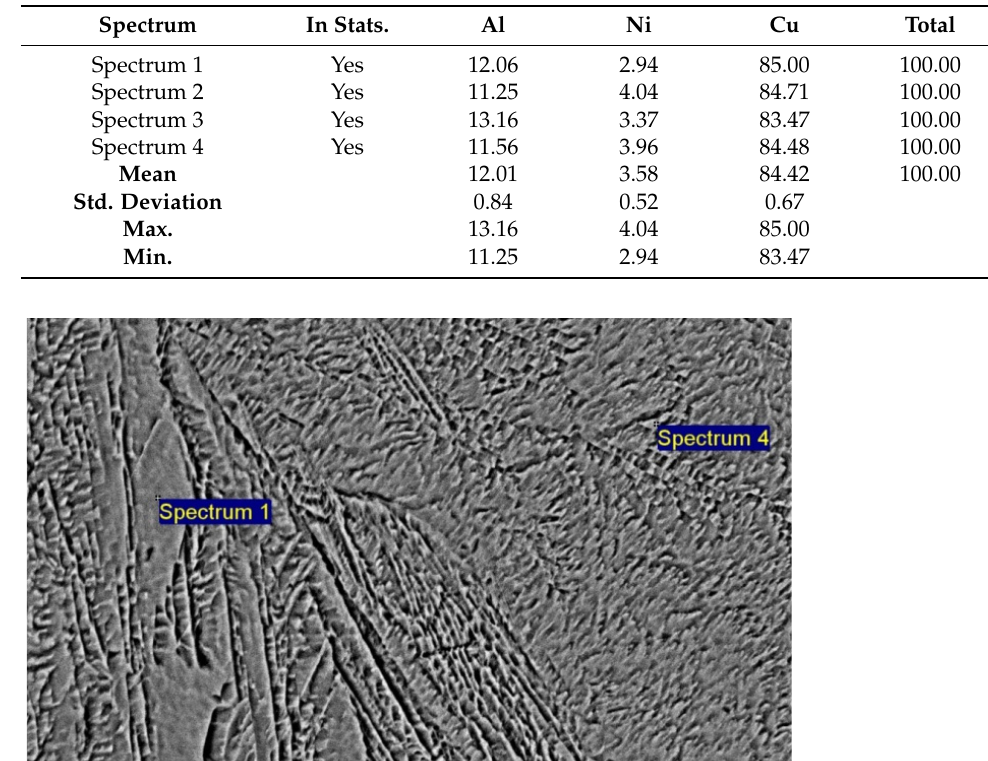
Table 3. Al, Ni, and Cu ions’ concentrations in artificial saliva pH = 6.5 and pH 4.5 after 7 days of immersion (values are given in µg/cm 2 ). pH= 6.5